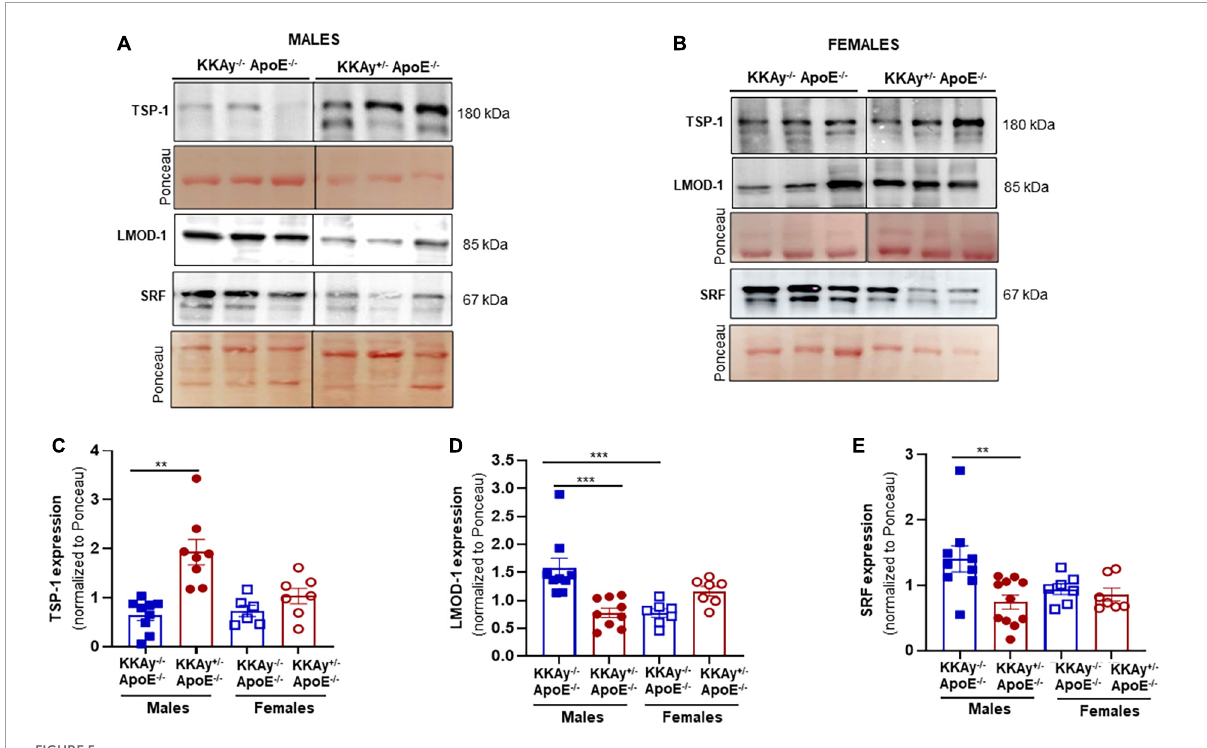
FIGURE5 Increased TSP-1 expression is accompanied with reduced LMOD-1 and SRF expression in MetS KKAy + / − ApoE − / − mice. Shown are (A) representative western blots for TSP-1, LMOD-1, and SRF expression in aortic lysates from male MetS KKAy + / − ApoE − / − and non-MetS KKAy − / − ApoE − / − mice; (B) representative western blots for TSP-1, LMOD-1, and SRF expression in aortic lysates from female MetS KKAy + / − ApoE − / − and non-MetS KKAy − / − ApoE − / − mice. Shown are summary graphs depicting densitometric quantification of western blots for panels (C) TSP-1; (D) LMOD-1, and (E) SRF expression (n = 6–11 animals per genotype per sex). Loading control = Ponceau S. Data shown illustrates protein expression normalized to Ponceau S. Results are expressed as mean ± SEM. ** p < 0.005; *** p < 0.0005. For each representative immunoblot, lane images depict proteins loaded and detected on a single immunoblot (full blots shown in Supplementary Figures 1, 2 ); however, lanes were re-arranged to improve the clarity of